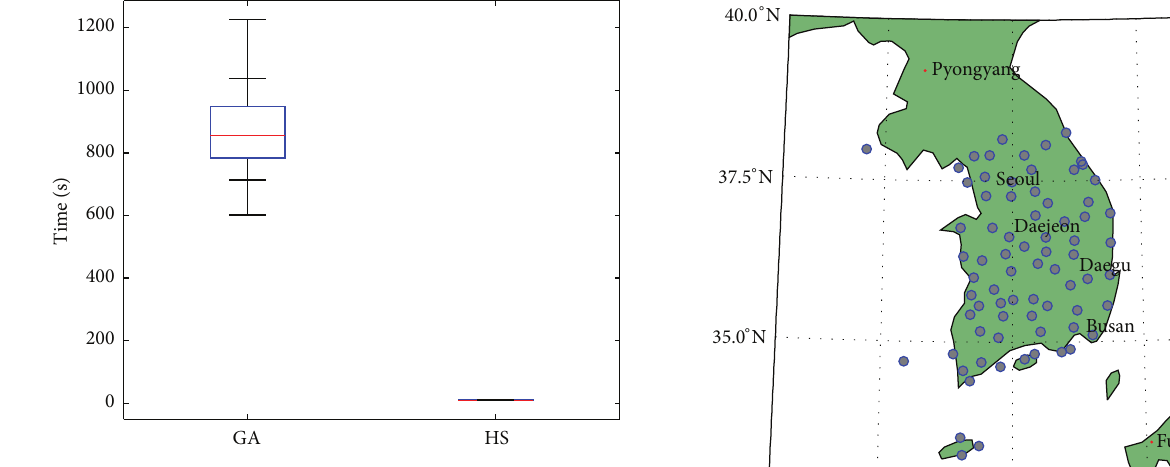
Figure 4: Boxplot of computation time for GEV parameter estima- tion using 100 simulations based on GA and HS techniques.